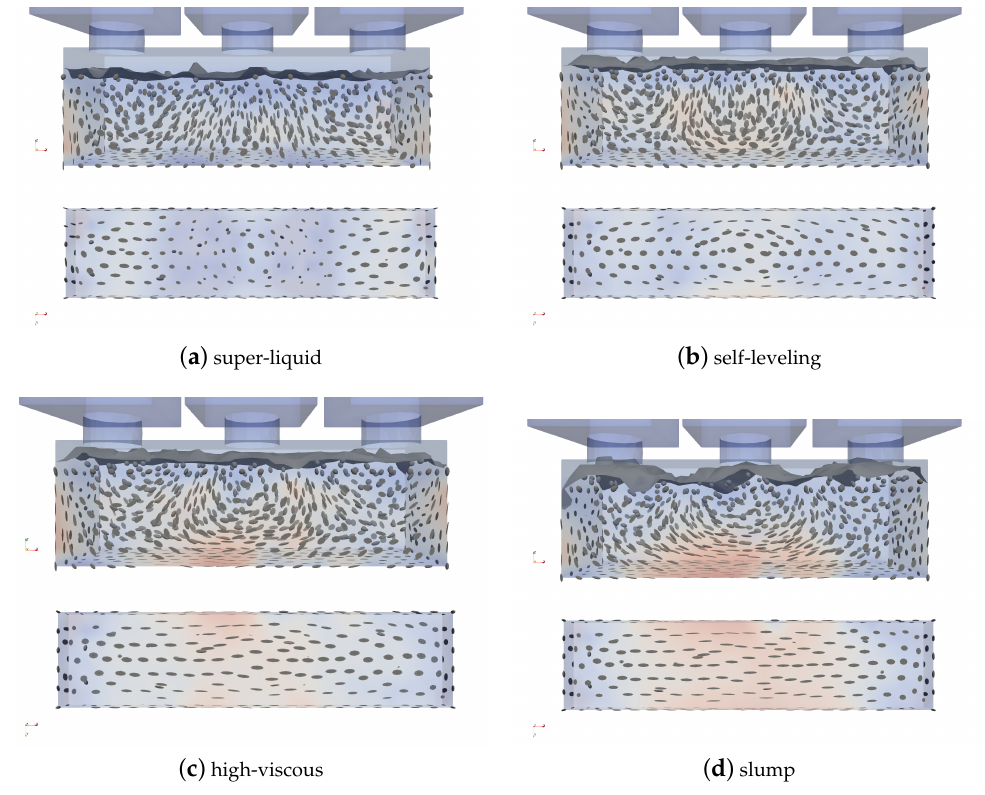
Figure 5. Comparison of the castings according to EN 14651 (first center, then edges) Table 4. Orientation parameters at two probe positions, the probes are located 2.5 cm above the bottom and centered in the other directions for probe 1, and 2.5 cm from the side wall and centered in the other directions for probe 2. The scalar-order parameter S is S = 3 ( λ − λ ) , b = sign ( S ) b , with the biaxiality b ∈ b S = 1 3 2 S 2 perfectly aligned fibers, S = 0 isotropic and S = − 1